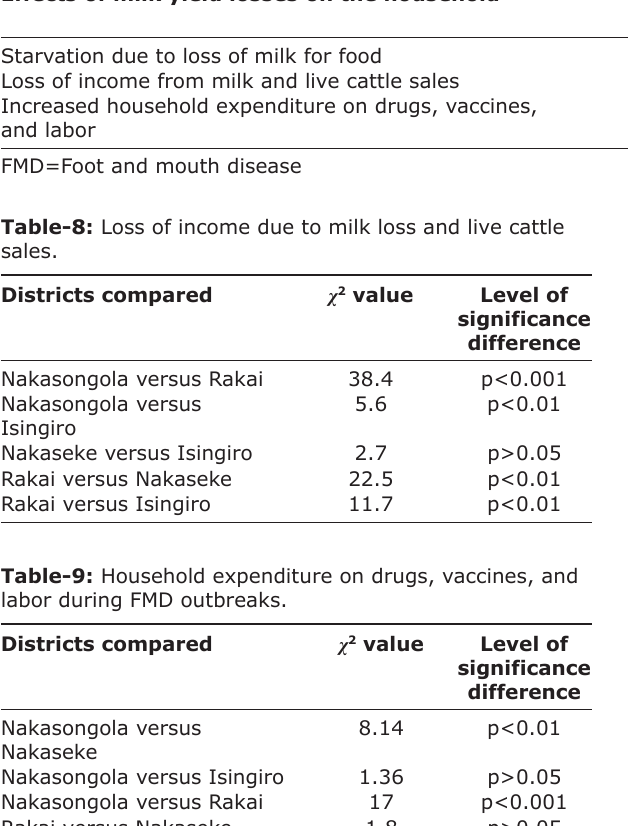
Table-7: Effects of milk yield loss (percentage) on households during FMD outbreaks. Effects of milk yield losses on the household